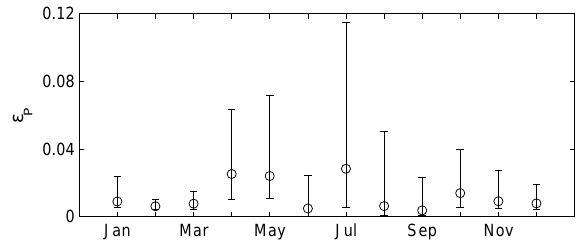
Fig. 7. Seasonal variation in retrieved precipitation emissivity at 934.5cm − 1 obtained at NSA-AAO between 2000 and 2003. Points are median values and bars the limits of the upper and lower quar-